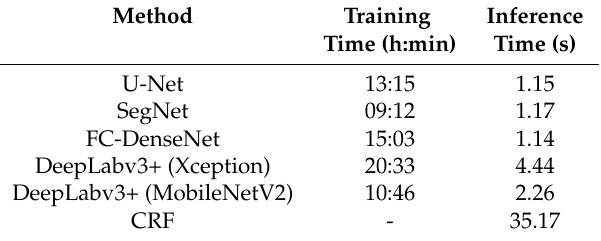
Table 3. Average processing time for each